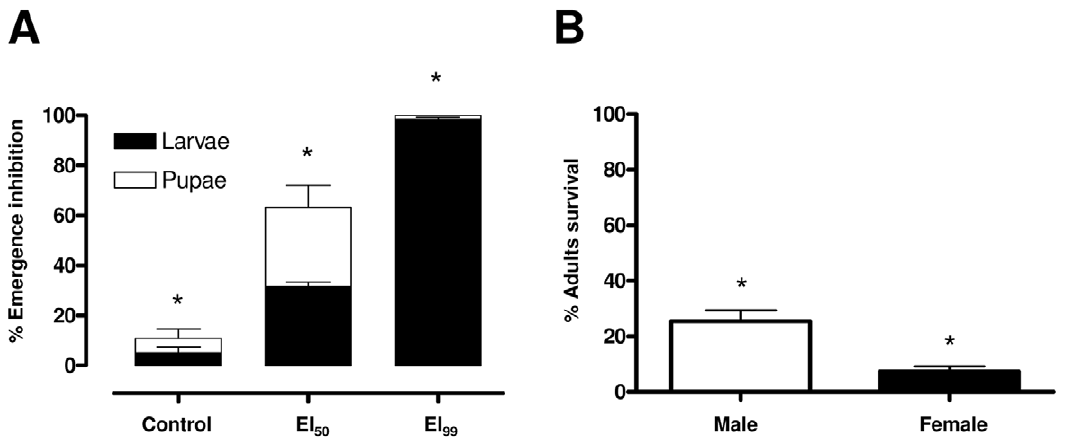
Figure 1. Novaluron inhibits Ae.aegypti adult emergence. ( A ) Dose-dependent effect of novaluron over emergence inhibition. EI 50 and EI 90 indicate novaluron concentrations resulting in emergence inhibition of 50 and 99% of adults, respectively. Black and white bars indicate death at larval and pupal stages, respectively ( B ) Percentage of surviving adults (males and females) after novaluron treatment (EI 50 ). Bars indicate mean and standard deviation of three experiments. Asterisks indicate significant differences (ANOVA, P , 0.05).